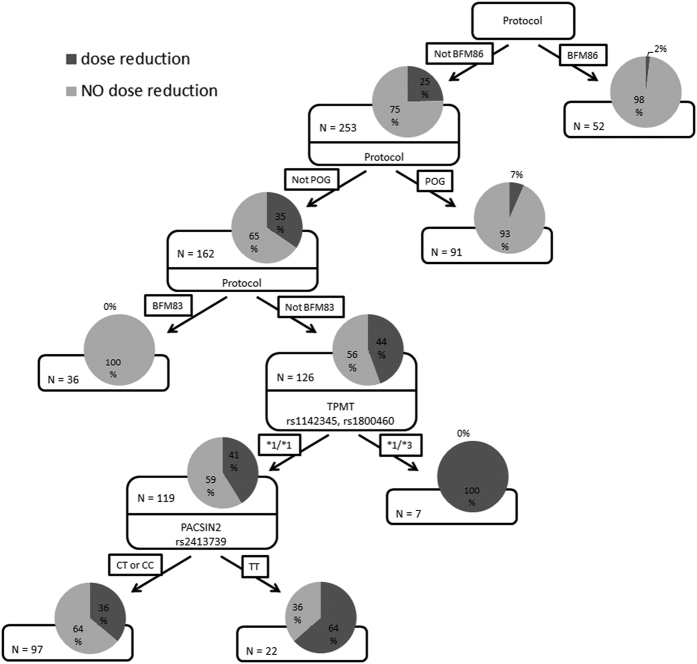
Results of CART analysis for dose reduction.Each branch of the tree is divided by genotype and other co-variables based on the information gain criterion. The following information is presented in each node: distribution pie chart with target class probability where “dose reduction” class is represented in dark gray and “NO dose reduction” in light gray, and number of patients in each node.